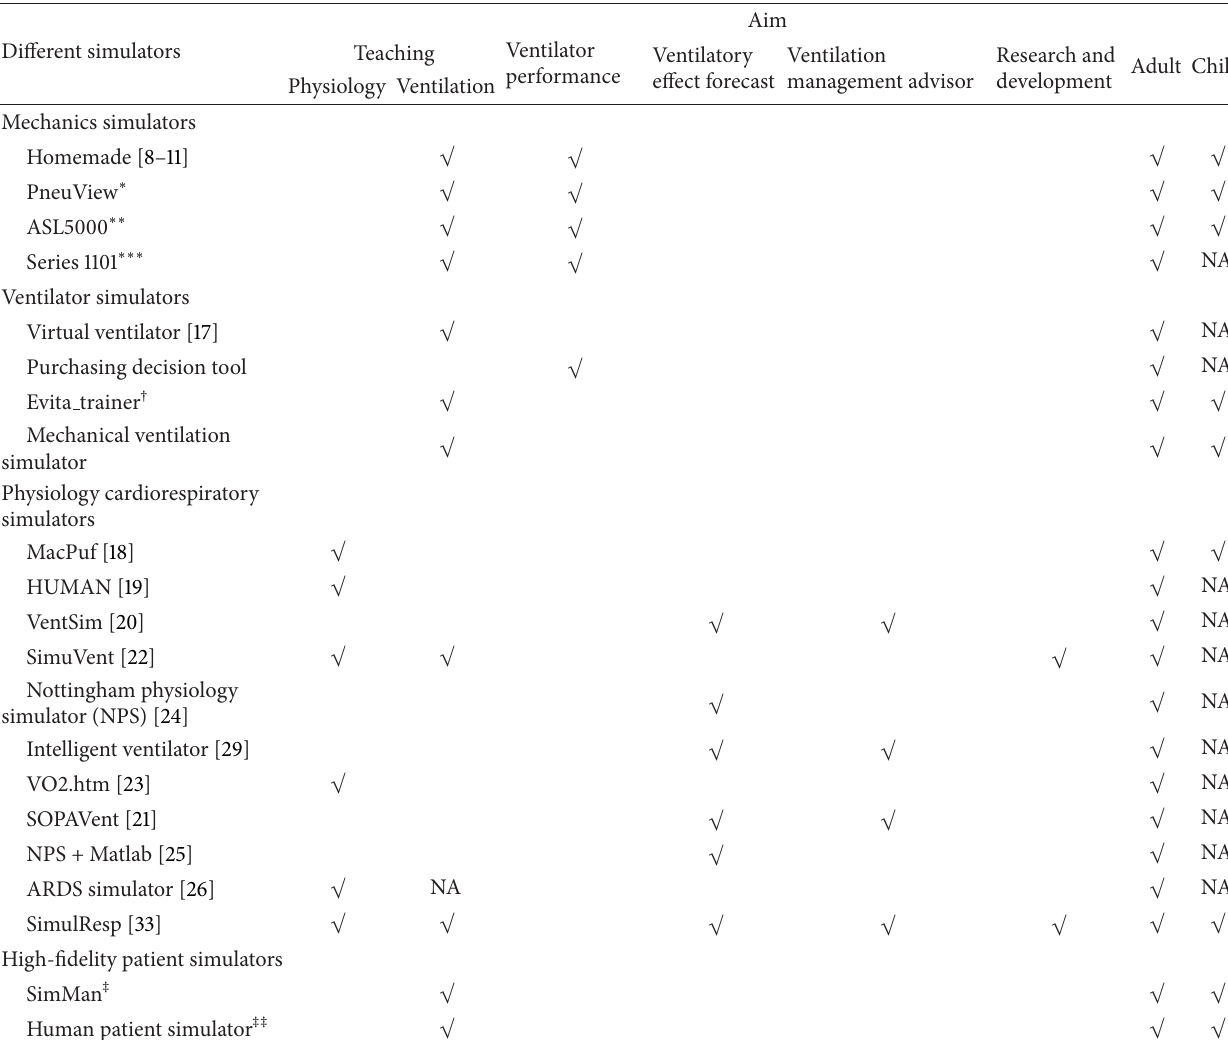
Table 1: Different types of simulators available in